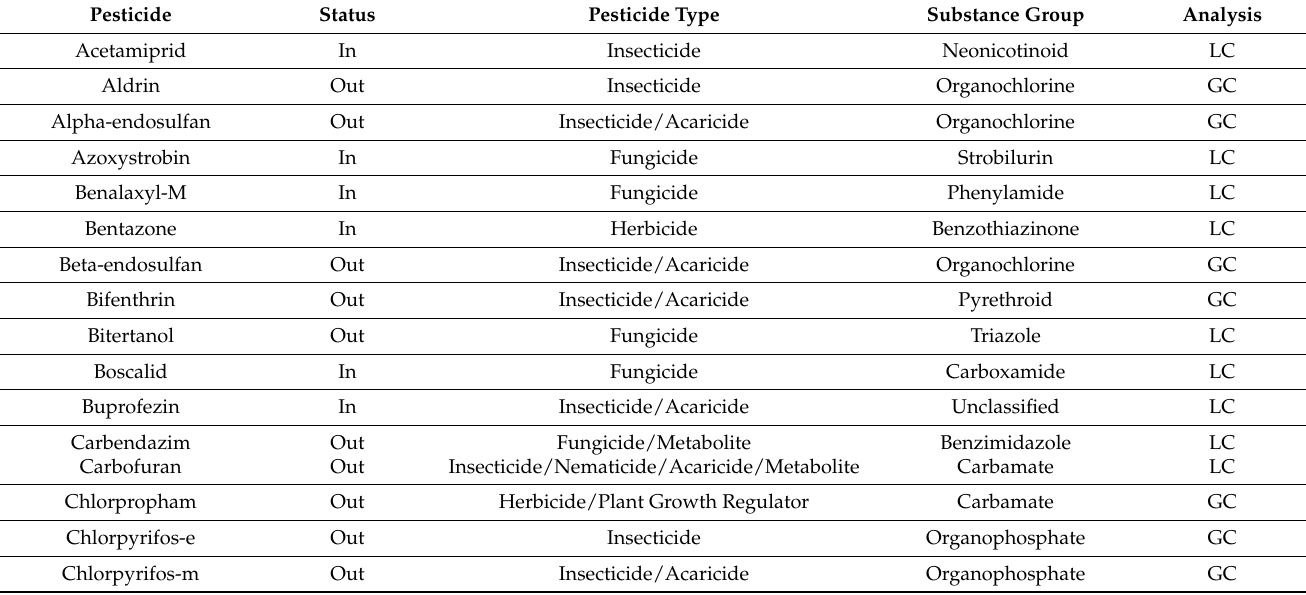
Table 1. Pesticides evaluated through the PESTNet